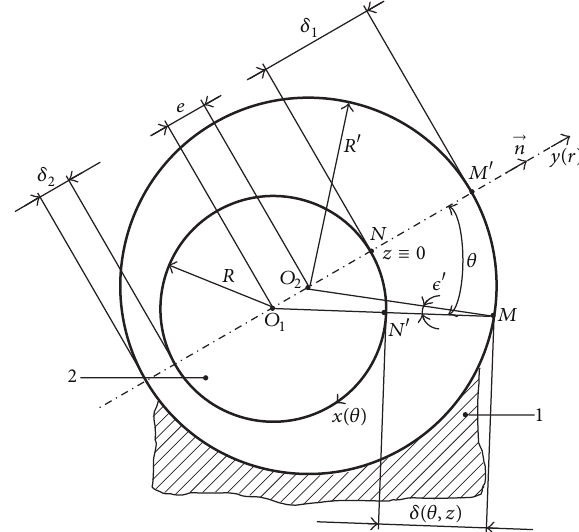
Figure 2: Geometrical and cinematic elements of the controllable turbulent hydraulic resistance with cylindrical